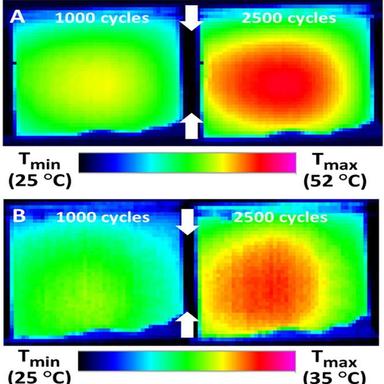
Typical TSA images of sample temperature (T) distribution at 70% of σuc part of the way into the 5000-cycle loading regime at that stress level. (A) Type A configuration stabilized at 51.34 °C, (B) Type B configuration stabilized at 32.13 °C. White arrows indicate compressive load direction.